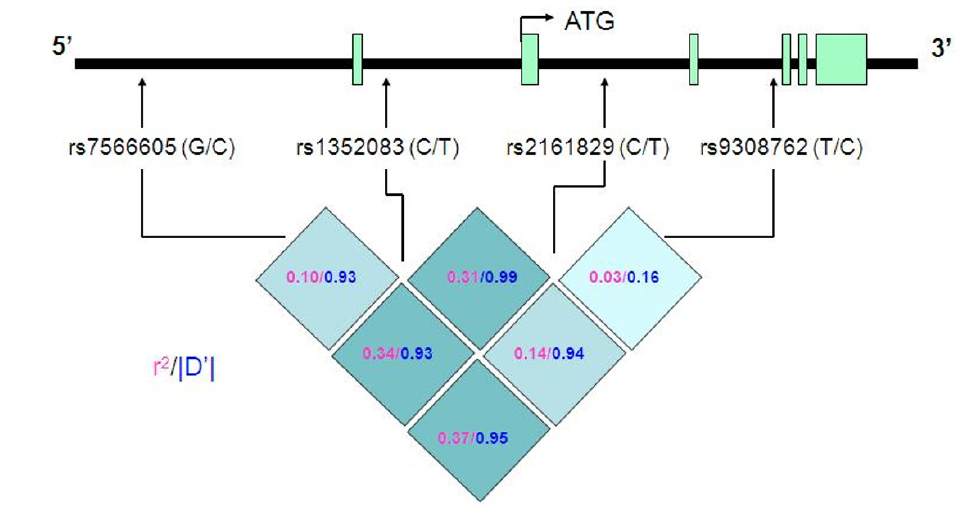
Schematic representation of the INSIG2 gene region showing the relative location of the tagging SNPs from 5' end to the 3' end of the gene . Allelic variants at each SNP are shown in parenthesis following the 'rs' numbers of the SNPs; the second allele at each locus represents the minor allele. Linkage disequilibria values, r 2 and D', among the SNPs are shown in the